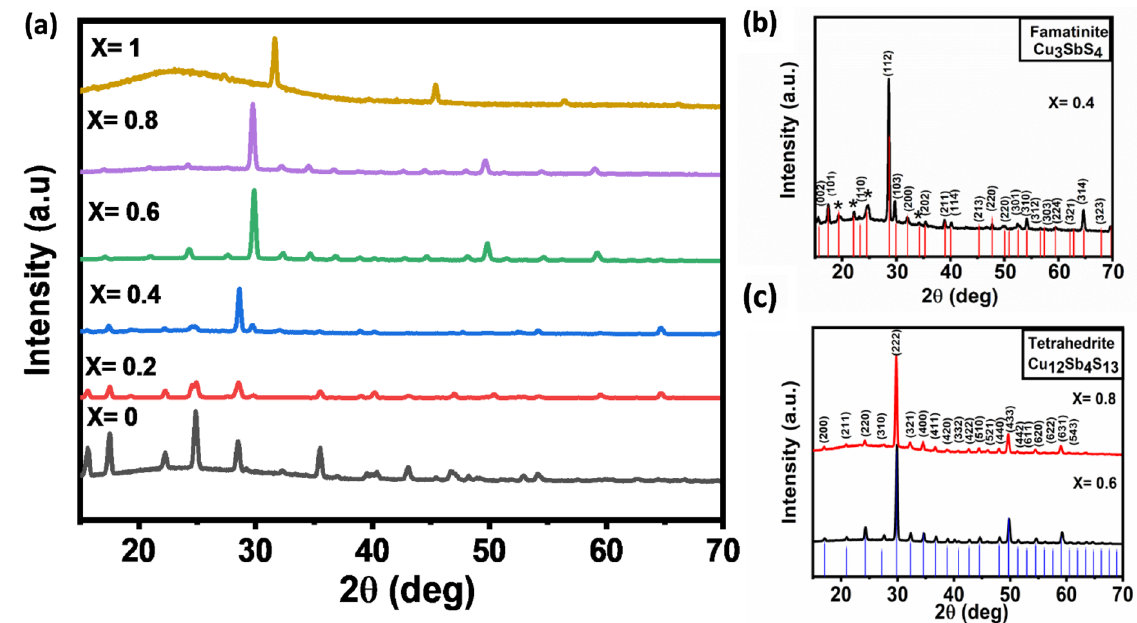
Figure 8. Plots showing the powder-XRD patterns for ( a ) all deposited Cu 2x Sb 2(1−x) S y thin films of x = 0, 0.2, 0.4, 0.6, 0.8 and 1. Also shown are the individual patterns for ( b ) x = 0.4 fematinite (Cu 3 SbS 4 , ICDD: 01-071-0555) and ( c ) x = 0.6 and x = 0.8 tetrahedrite (Cu 12 Sb 4 S 13 , ICDD:01-088-0283). These spectra were recorded on the AACVD thin films, deposited at 450 °C.